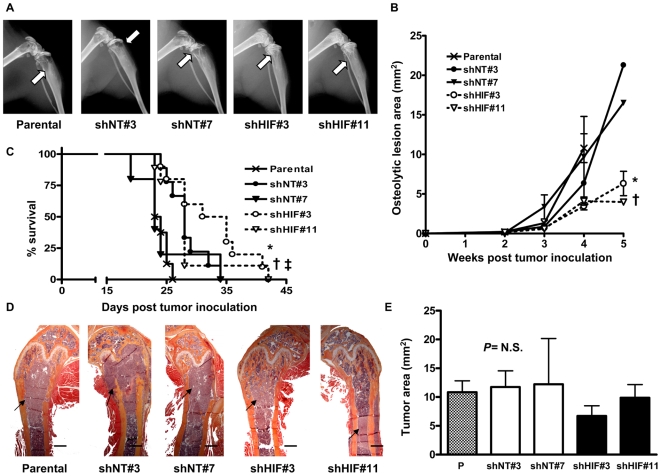
Knockdown of HIF-1α decreases osteolytic lesions and improves survival of mice in vivo.(A) Representative x-ray images from hindlimbs of mice 4 weeks post inoculation with MDA-MB-231 parental, shNT and shHIF cells. Arrows indicate osteolytic lesions. (B) Osteolytic lesion area measured on radiographs of hindlimbs and forelimbs of mice with bone metastases. Results are expressed as the mean area ± SEM per mouse (n = 5–10 per group). † P<0.01 and * P<0.001 compared to parental or shNT clones using a two-way ANOVA with a Bonferroni post-test at 4 weeks. (C) Kaplan-Meyer analysis of mouse survival. * P<0.05 shHIF#3 compared to Parental or shNT clones, † P<0.005 and ‡ P = 0.089 shHIF#11 respectively compared to Parental and shNT#7 using a Logrank test. (D) Representative histology of femurs with tumor indicated by arrows. Scale bar equal to 500 µm. (E) Tumor burden in hindlimbs was measured by quantitative histomorphometry. Results are expressed as the mean ± SEM area per bone. A one-way ANOVA with a Newman-Keuls multiple comparison test showed no significant differences (N.S.) between groups.